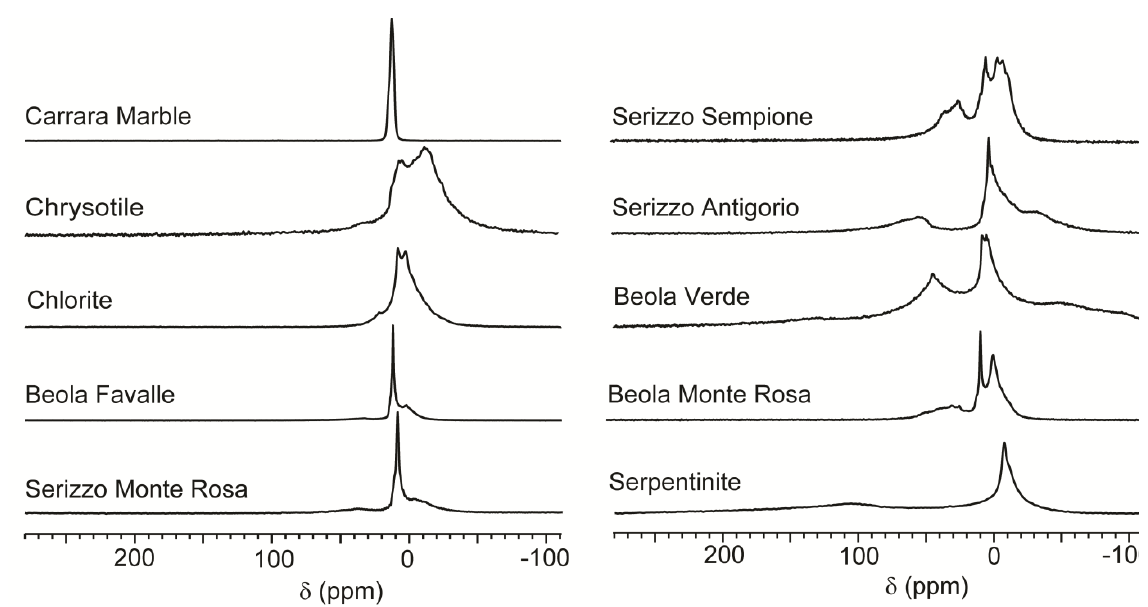
Figure 2. Continuous flow hyperpolarized xenon (CF-HP) 129 Xe spectra of mineral and rock samples. Signal intensities were normalized arbitrarily to similar height for a more immediate